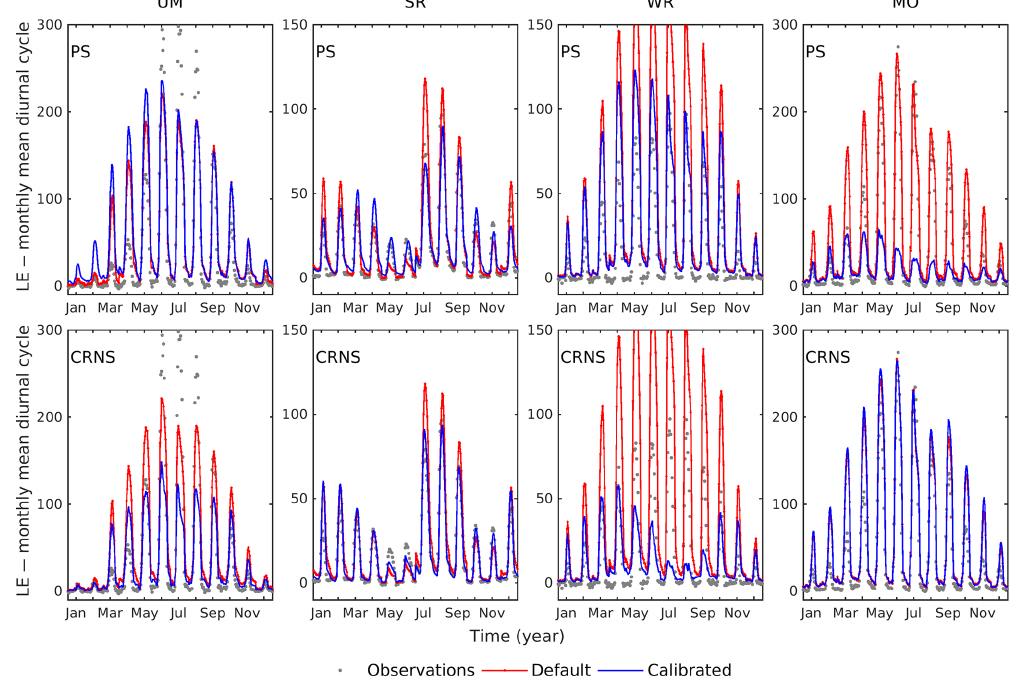
Figure 7. Monthly mean diurnal latent heat flux (LE) cycles. The upper row contains PS calibrated solutions, and the lower row shows the CRNS calibrated solutions.